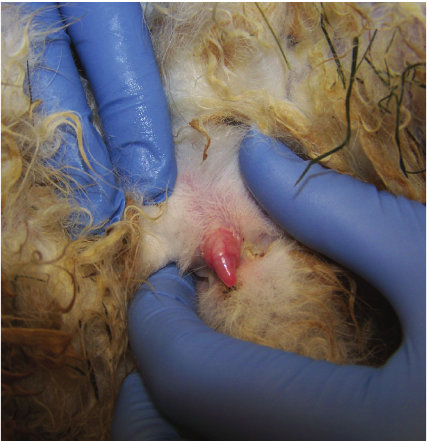
Figure 1: Clitoral enlargement in a 10-year-old, spayed female